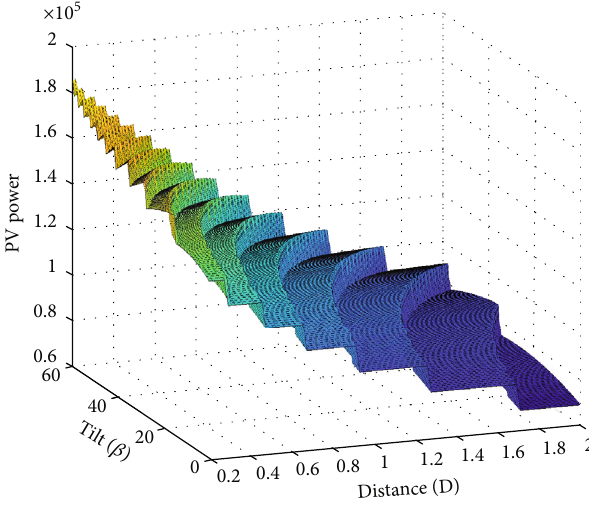
) variations on the SPV power. pv